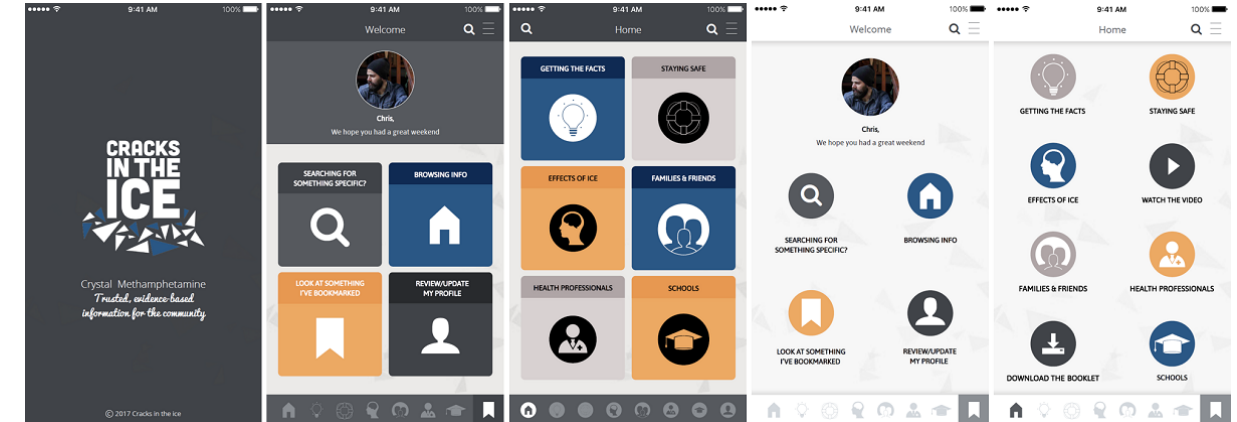
Figure 2. Example preliminary design